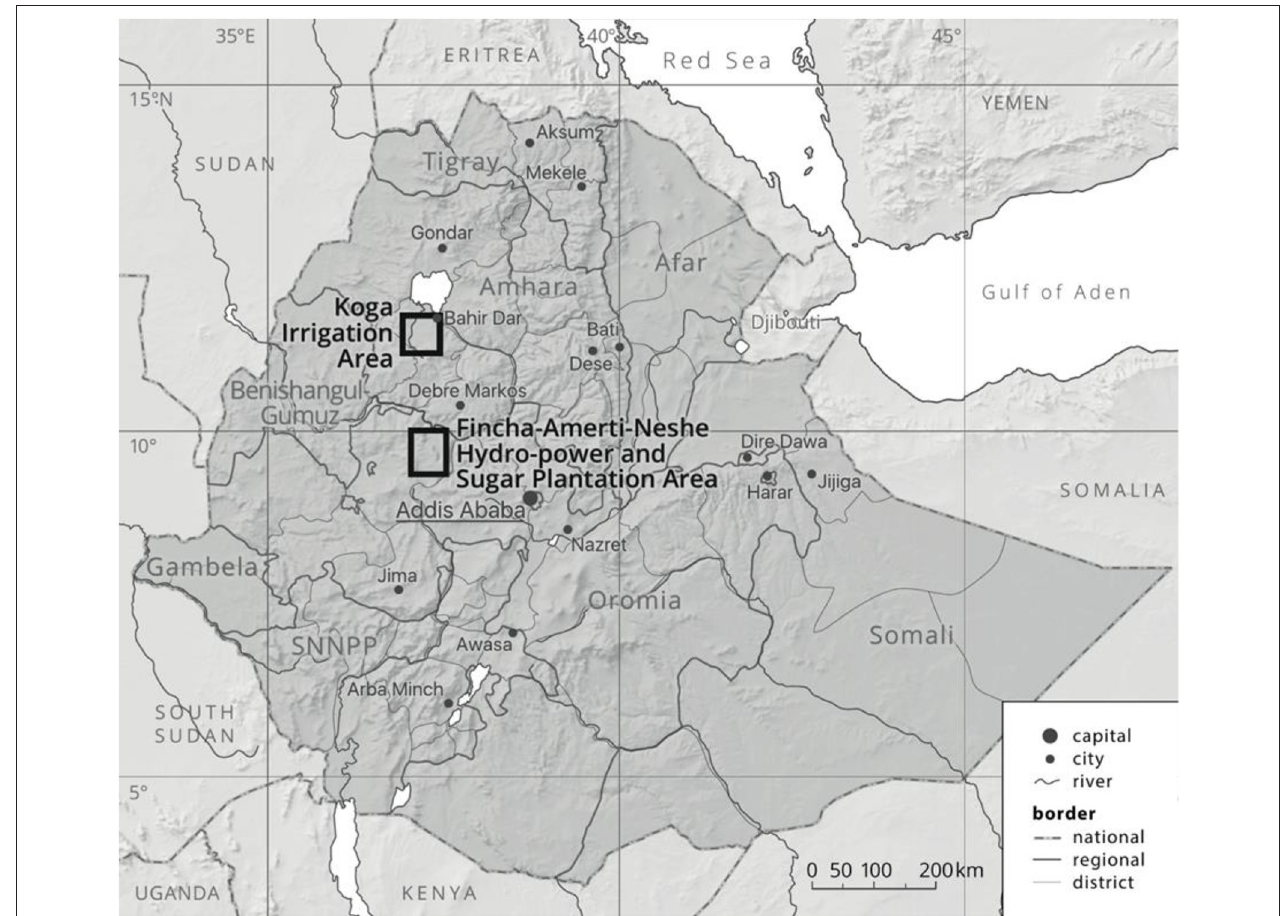
FIGURE 1 | Map of Ethiopia and the two case study